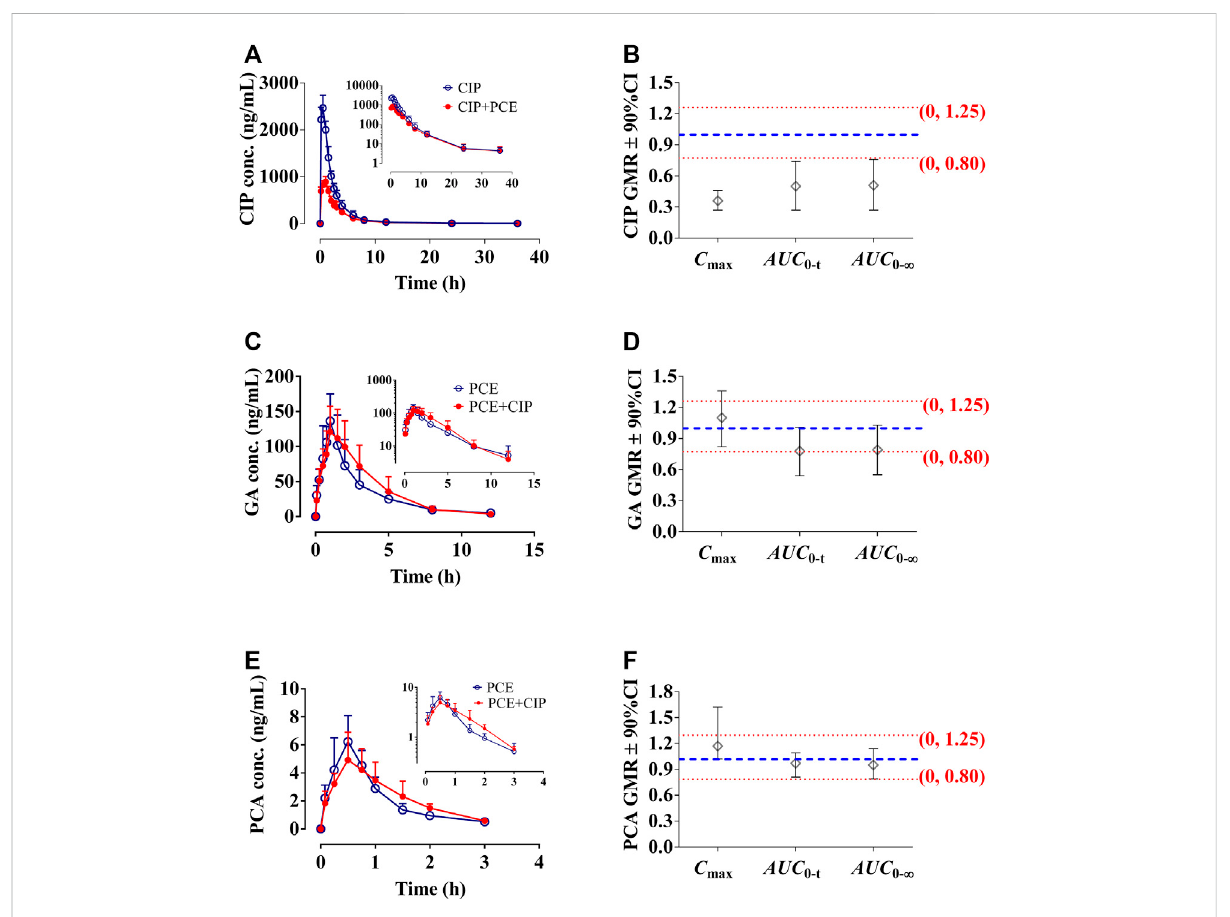
FIGURE 5 Circulatingcipro fl oxacin(CIP)concentration-timepro fi les (A) a ndthe90%con fi denceintervals(CI)forthegeometricmeanratios[GMR, (B) ]of C max , AUC 0-t and AUC 0- ∞ in the presence and absence of PCE to rats, as well as gallic acid [GA, (C,D) ] and protocatechuic acid [(PCA, (E,F) ] in the presence and absence of CIP (mean ± SD, n = 6).